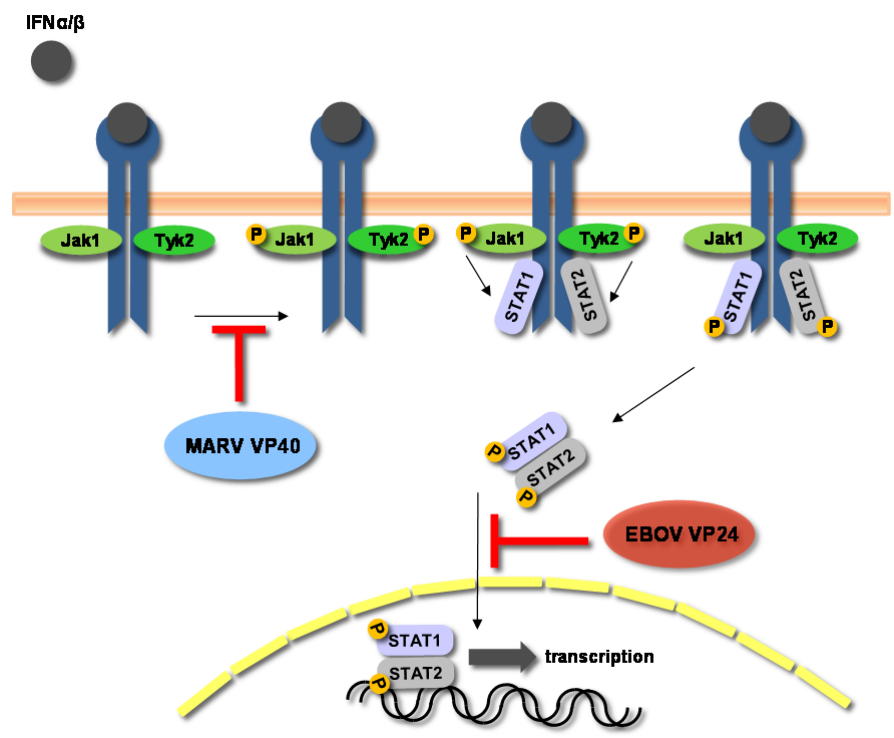
Figure 6. Inhibition of JAK-STAT signaling by filoviruses. MARV VP40 inhibits phosphorylation of Janus kinases and STAT proteins in response to Type I and II IFNs and IL6, preventing downstream signaling. Phosphorylation of STAT proteins is not inhibited by Ebola virus (EBOV). EBOV VP24 interacts with STAT1 and members of the nuclear importin family and prevents nuclear translocation of phosphorylated